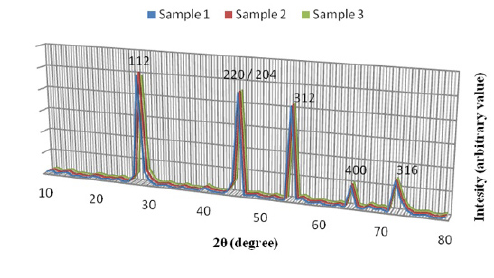
Figure 8. XRD patterns of CuInSe 2